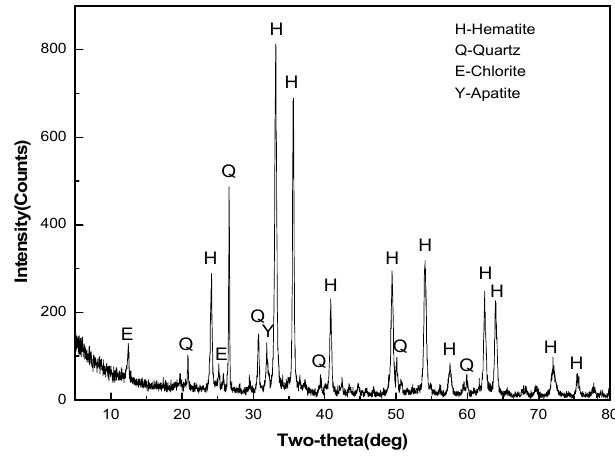
Figure 1. X-ray diffraction pattern of the oolitic hematite ore. Figure 1. X ‐ ray diffraction pattern of the oolitic hematite ore. Table 2. Chemical phases and distribution of phosphorus in oolitic hematite ore /wt. %.